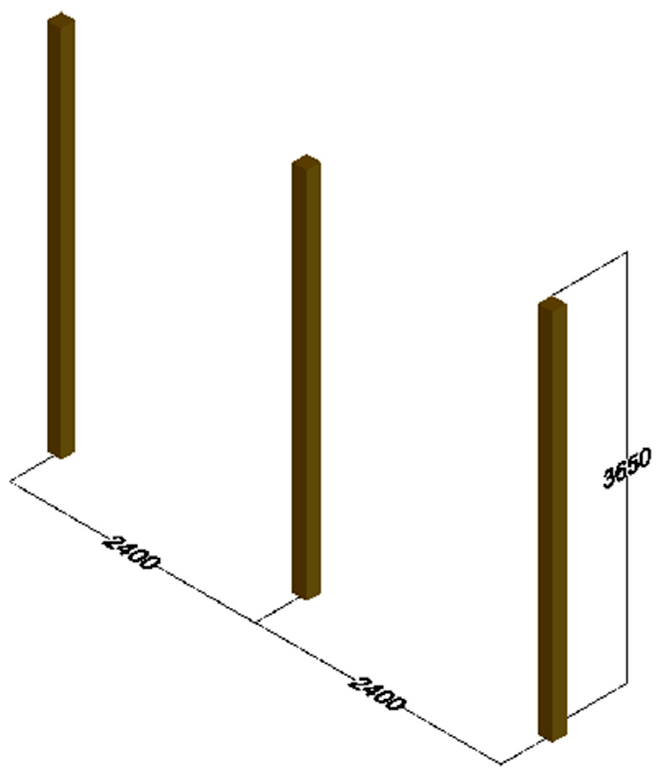
Figure 1. Post arrangement of a 2-section system. This arrangement can be continued to include as many sections as desired.